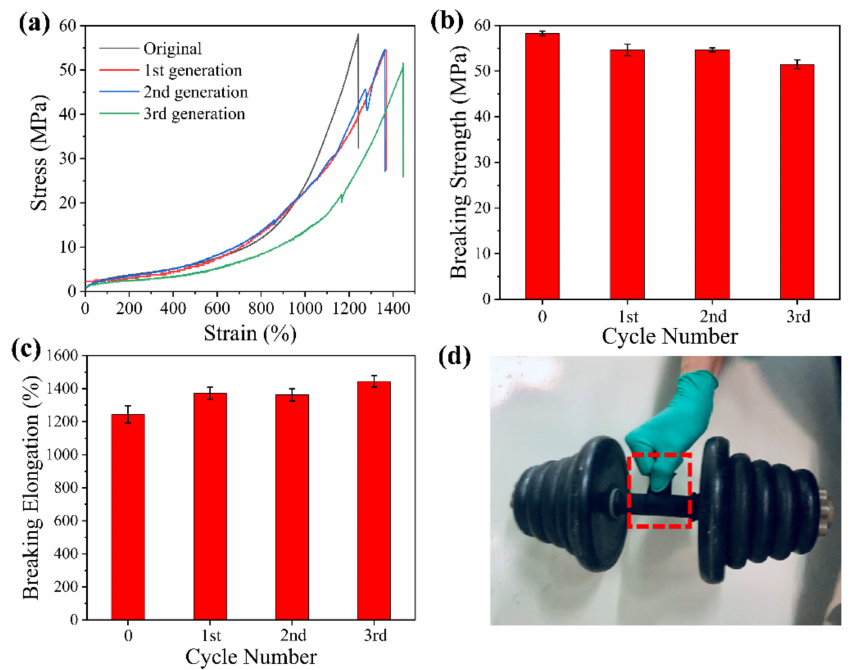
Figure 12. ( a ) Stress–strain curves of PWPU 10,000 after three generations of recycling. ( b ) Breaking strength and ( c ) breaking elongation of the PWPU 10,000 samples after three recycling processes. ( d ) Photo of lifting a 10 kg weight with a PWPU 10,000 film with the thickness of 0.3 mm after the recycling